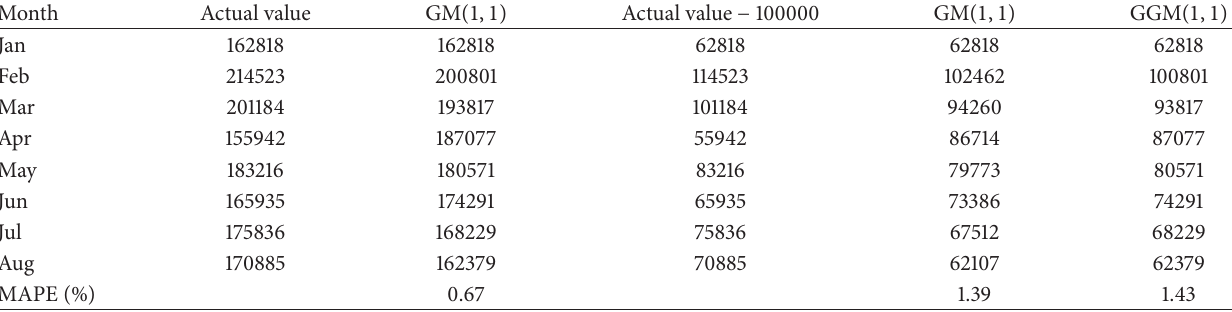
Table 2: Simulation by GM( 1, 1 ) and GGM( 1, 1 ).